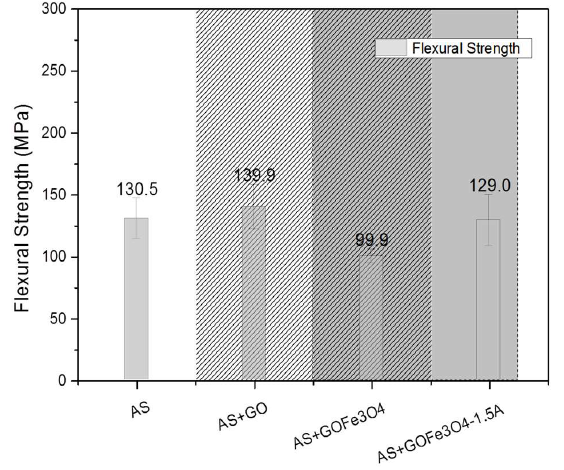
Figure 9. Effect of the magnetic field on the flexural Strength of the final laminates.